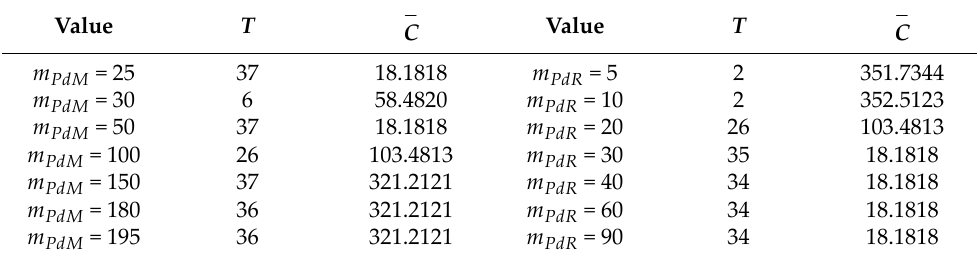
Table 4. Optimal results for different m PdM and m PdR .